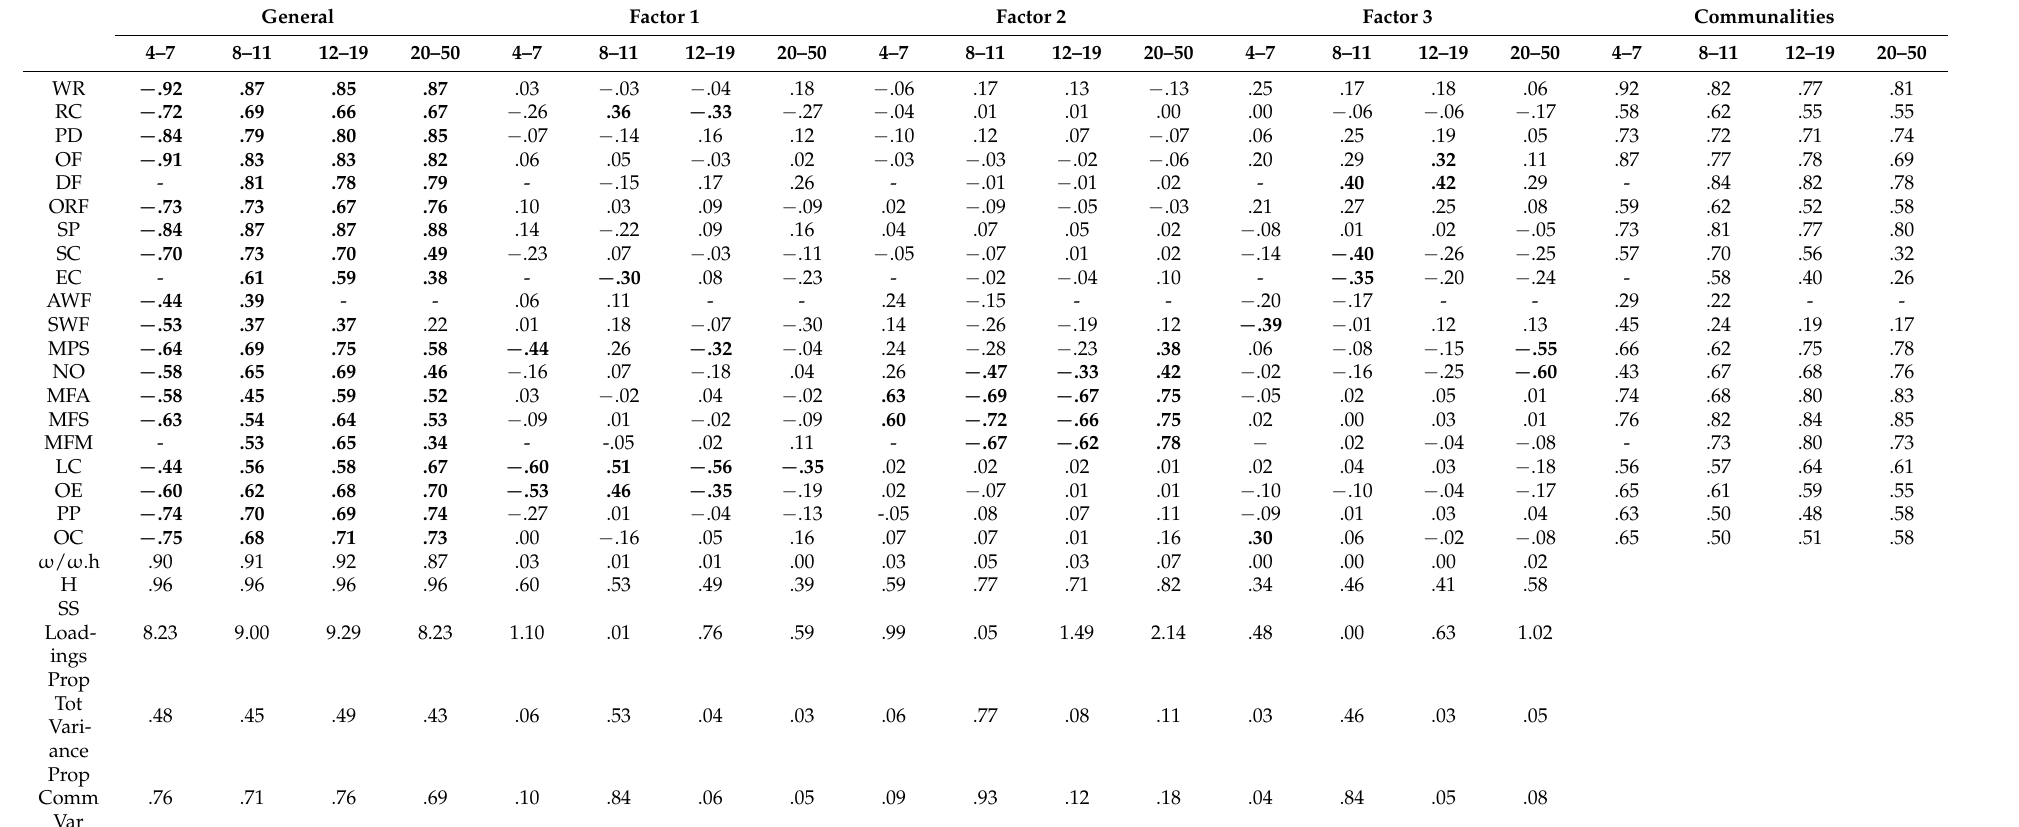
Table A7. Bifactor Solution with Three Specific Factors Across Age